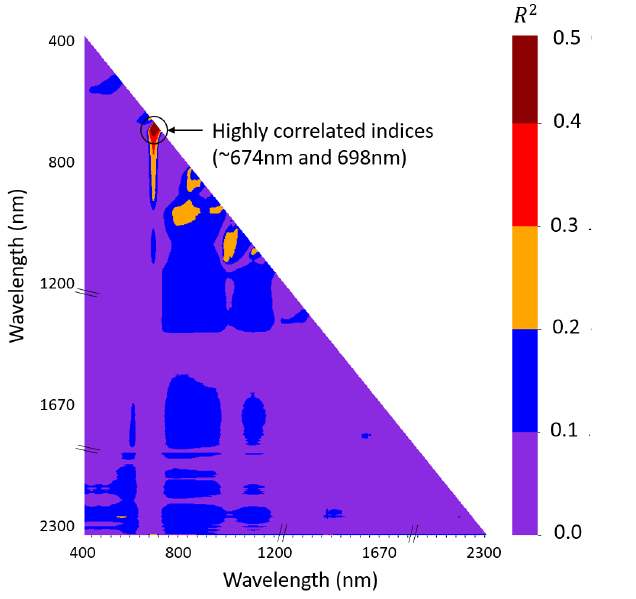
Figure 6. Correlation heatmap of two-band normalized difference index with the strawberry water content. Red- and orange-shaded areas highlight wavelengths involved in most informative indices. The line break symbols on the wavelength axes indicate the omission of noisy wavelengths, as explained in Section